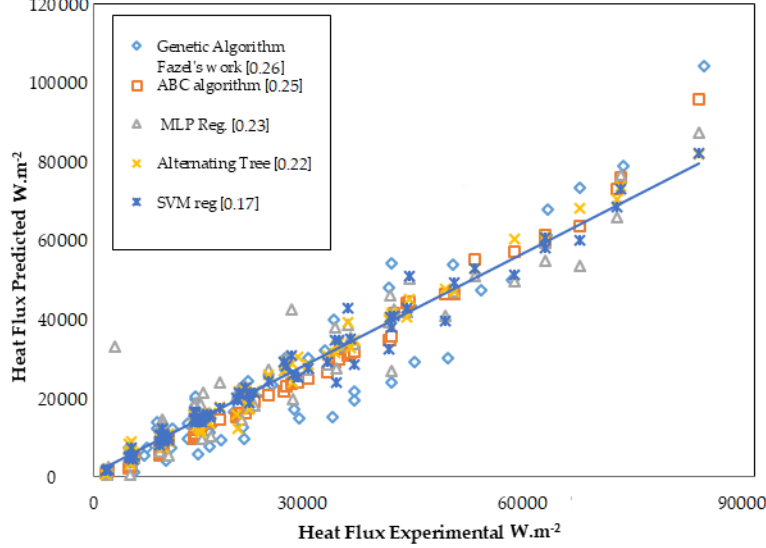
Figure 8. The comparison of black-box techniques to white-box techniques.